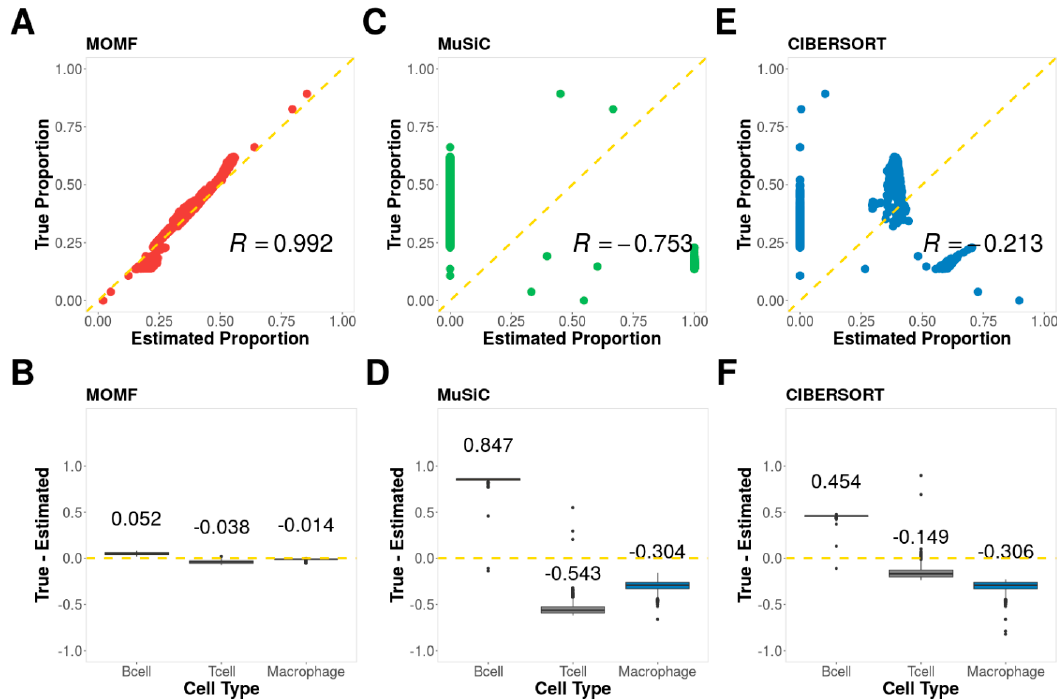
Figure 2. Simulation results. The simulated data based three cell types, B cells, T cells, and Macrophage cells. ( A ) The scatter plot of ground truth and cell type proportion estimated by MOMF; ( B ) The boxplot to show the difference between ground truth and cell type proportion estimated by MOMF ( C ) The scatter plot of ground truth and cell type proportion estimated by MuSiC; ( D ) The boxplot to show the difference between ground truth and cell type proportion estimated by MuSiC ( E ) The scatter plot of ground truth and cell type proportion estimated by CIBERSORT; ( F ) The boxplot to show the difference between ground truth and cell type proportion estimated by CIBERSORT. R: Pearson correlation.